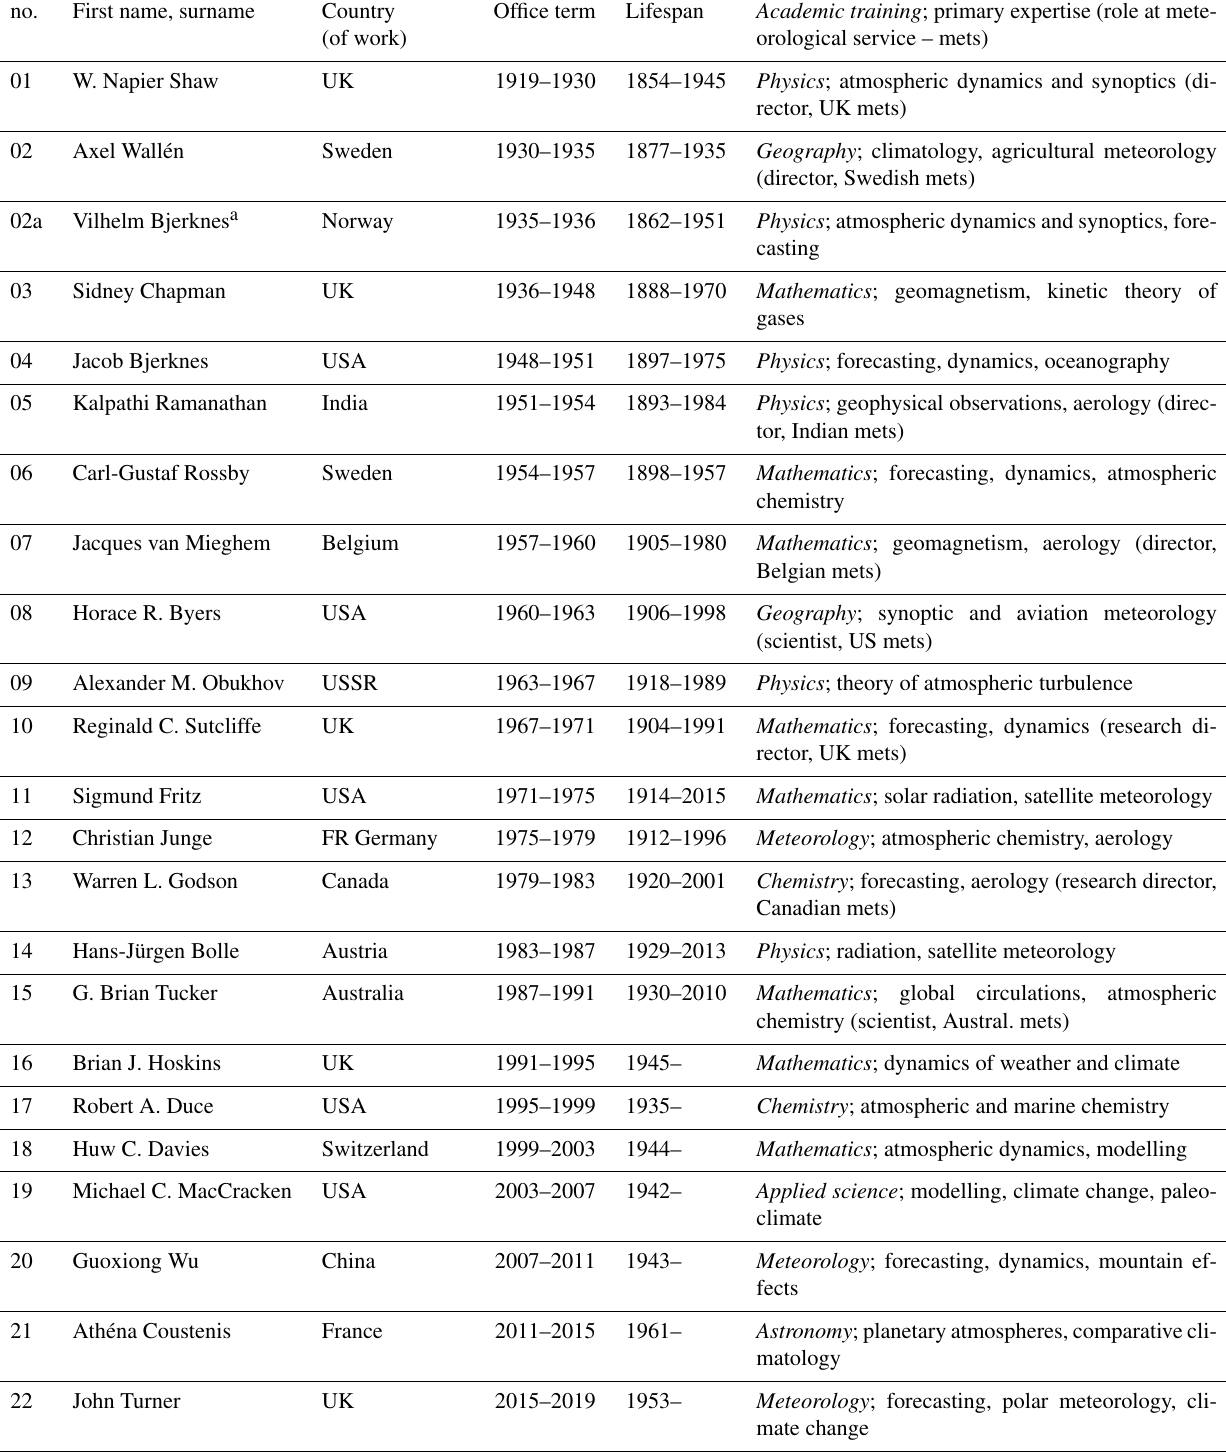
Table 2. Succinct biographical information about the 23 persons who have served as IAMAS presidents; photographs are presented in Fig. 3. Under academic training, the subject of graduation is listed (typically for a PhD or MSc